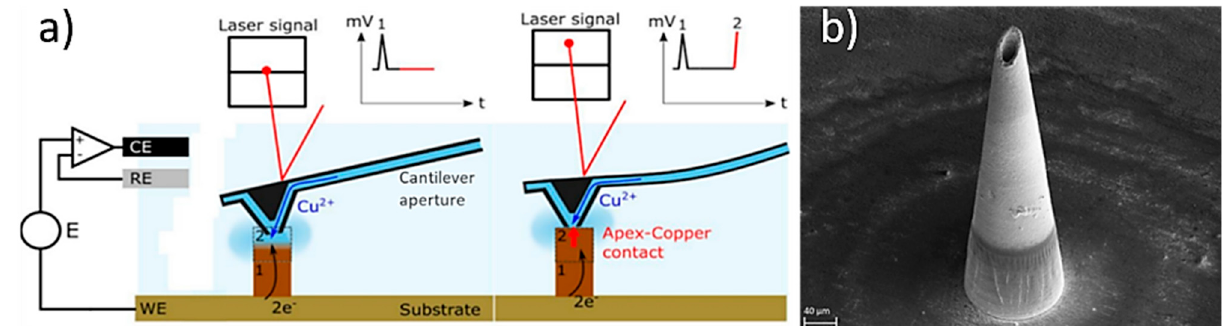
Figure 10. ( a ) Schematic of the printing process inside the printing chamber, whereby the copper ions are injected through a cantilever aperture to create the final part. Initially the computer provide the order to the positioning control which regulates the additive manufacturing process by an embedded controller, the cantilever is moving using the Z-stage inside the printing chamber, and the electrolyte flow via the cantilever is modulated by the microfluidics control, and ( b ) hollow MN produced by the electroplating/Additive Manufacturing process